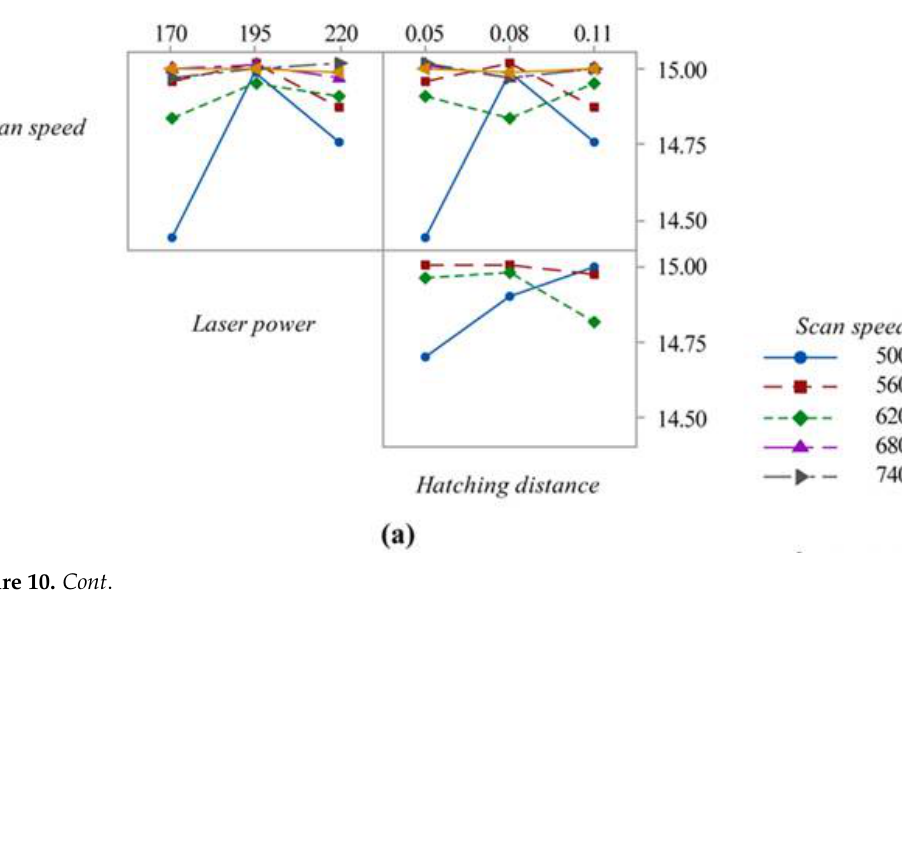
Figure 9. Accuracy in x- and y-directions.